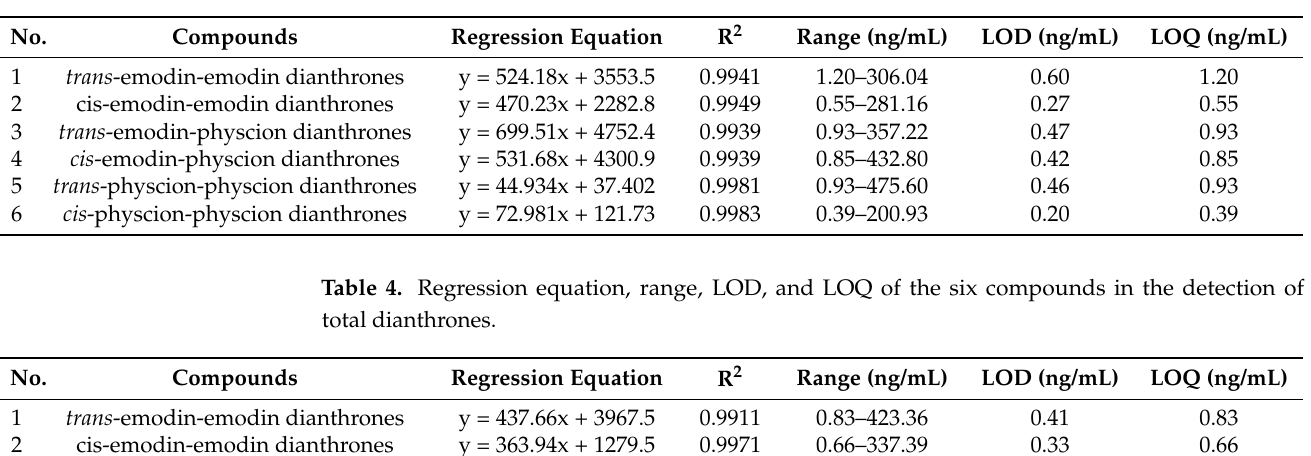
Table 3. Regression equation, range, LOD, and LOQ of the six compounds in the detection of free dianthrones.